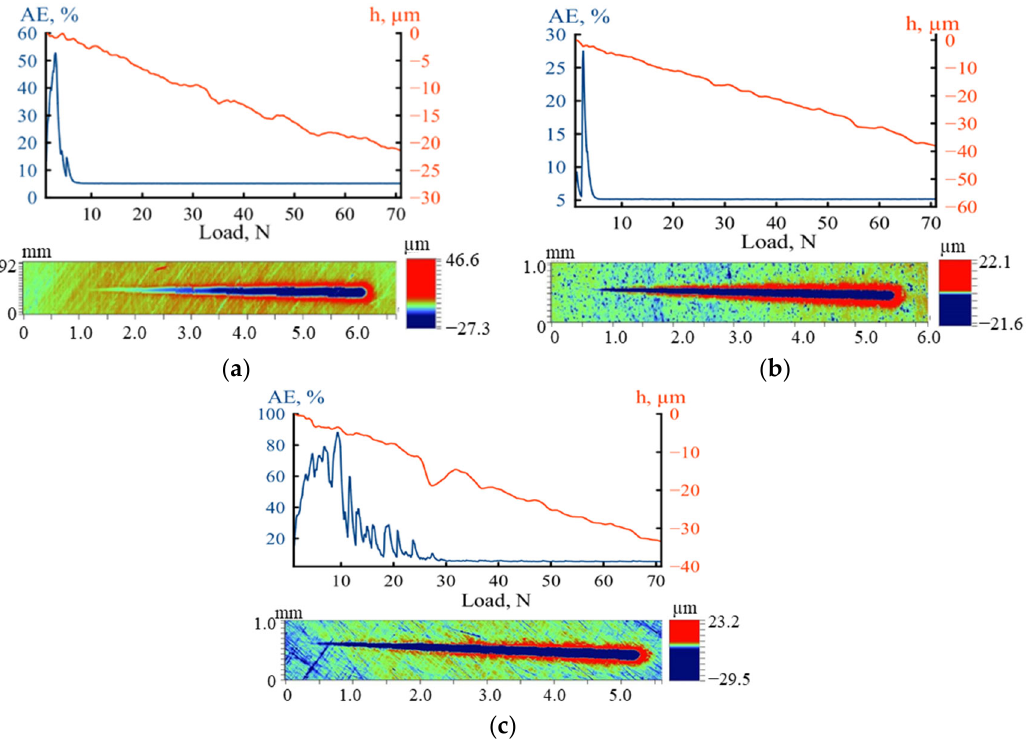
Figure 2. Scratch ‐ test parameters as a function of indenter load and the scratch profiles after testing of Mo ‐ Zr ‐ Si ‐ B coatings deposited by HIPIMS at frequencies of 10 ( a ), 50 ( b ), and 200 Hz ( c ). The minimal penetration depth was observed for the coating deposited at 50 Hz.